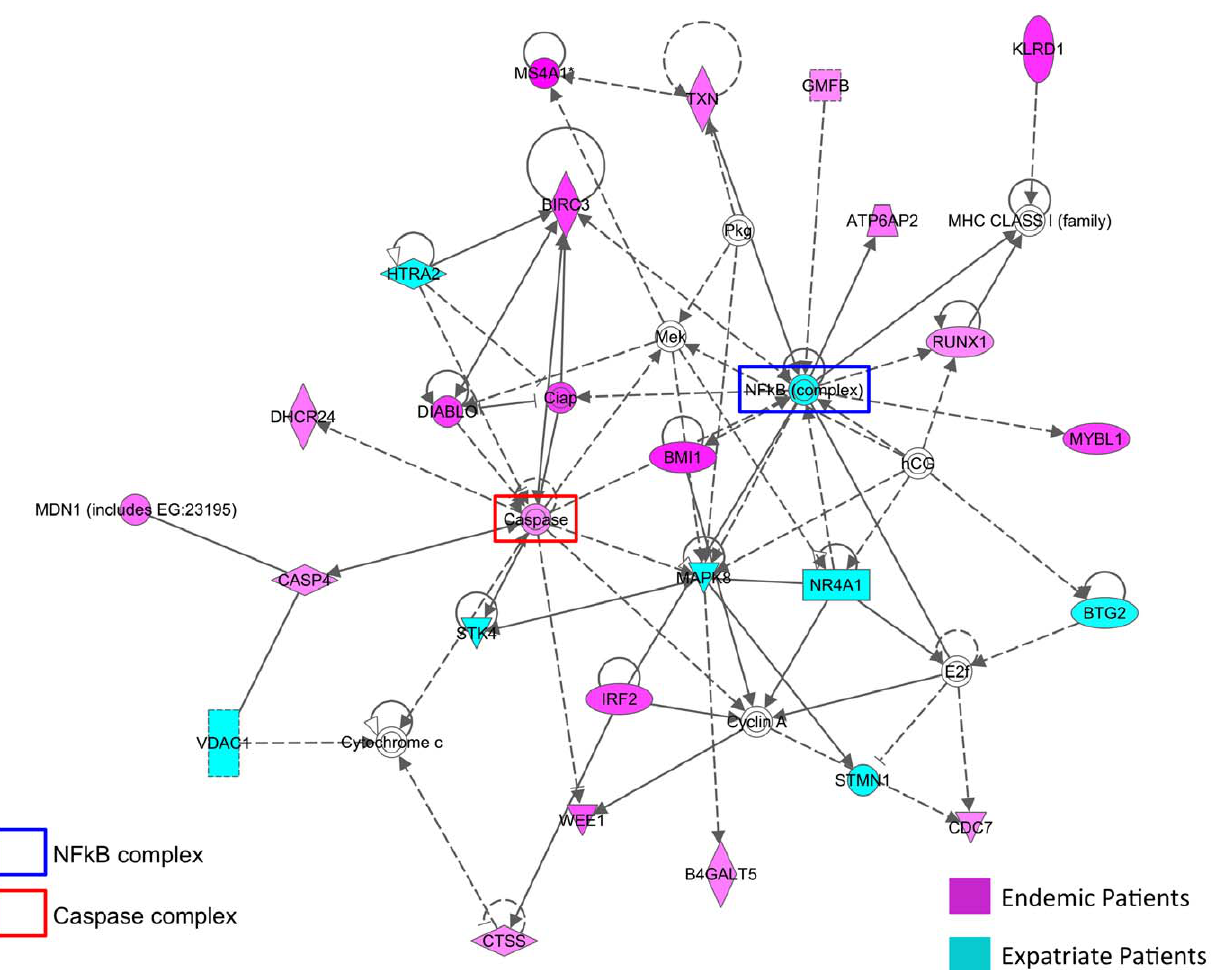
Figure 4. Cell death network in unstimulated cells. Network of differentially expressed molecules associated with cell death (www.ingenuity. com) in the unstimulated CD4 + and CD8 + T cells of endemic (in red) and expatriate (in blue) patients. Genes were differentially expressed at p , 0.01, adjusted for multiple comparisons using the Benjamini Hochberg False Discovery Rate (FDR) correction. Lines represent direct (solid lines) and indirect (dashed lines) relationships between molecules and molecules within double circles represent complexes of